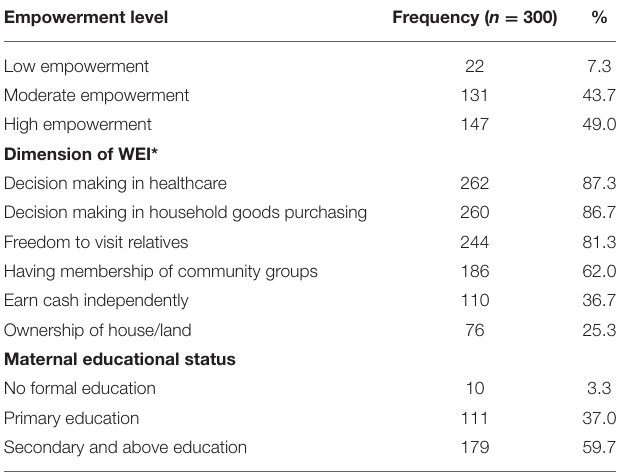
TABLE 1 | Socio-demographic characteristics (n = 300). TABLE 2 | Maternal empowerment and its various